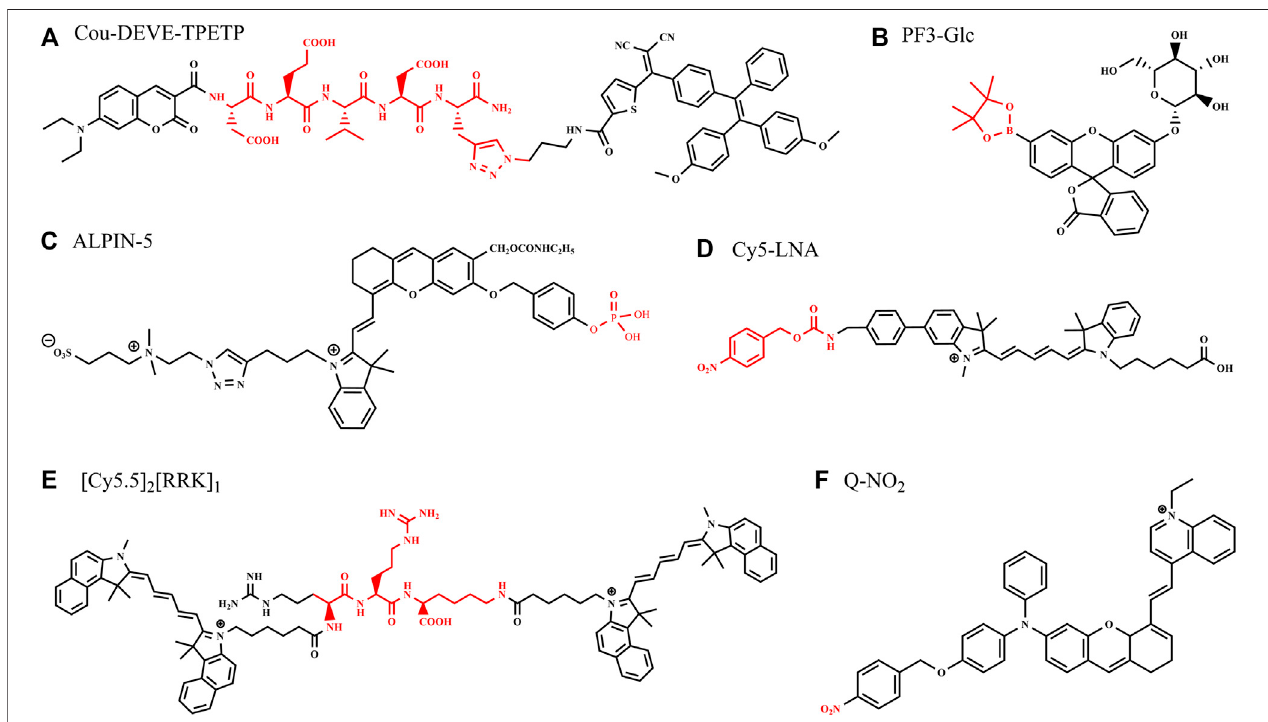
FIGURE 1 | Structures of some bioimaging probes activated with single enzyme.